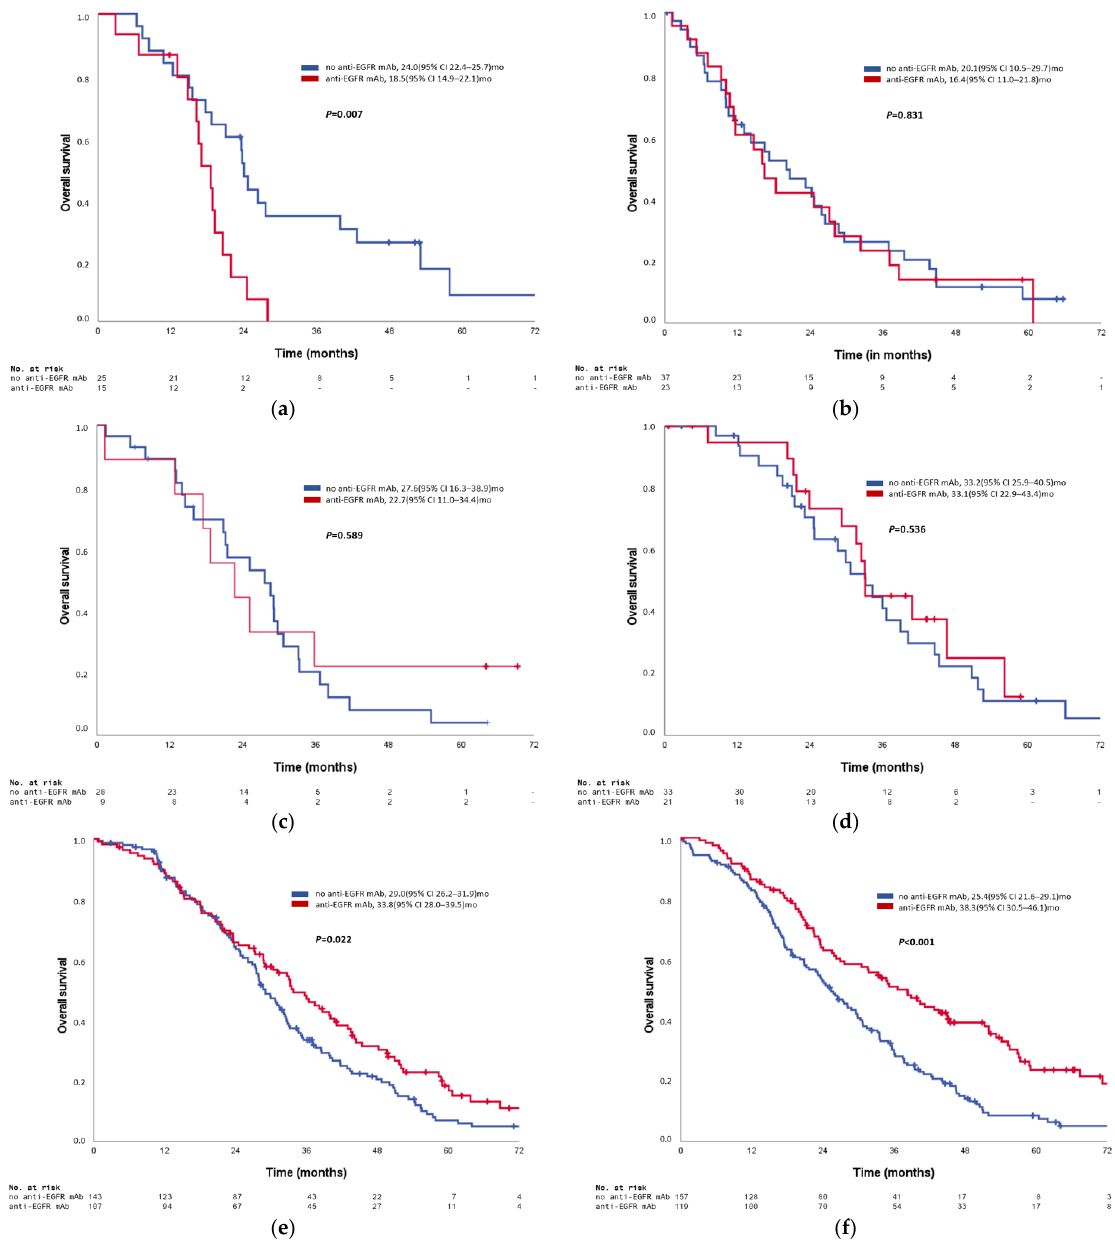
Figure 2. Kaplan – Meier estimates of overall survival according to exact primary tumor location ( a ) Kaplan–Meier estimates of overall survival in RAS/BRAF wild-type mCRC with primary tumor location in the caecum according to anti-EGFR use. ( b ) Kaplan–Meier estimates of overall survival in RAS/BRAF wild-type mCRC with primary tumor location in the ascending colon according to